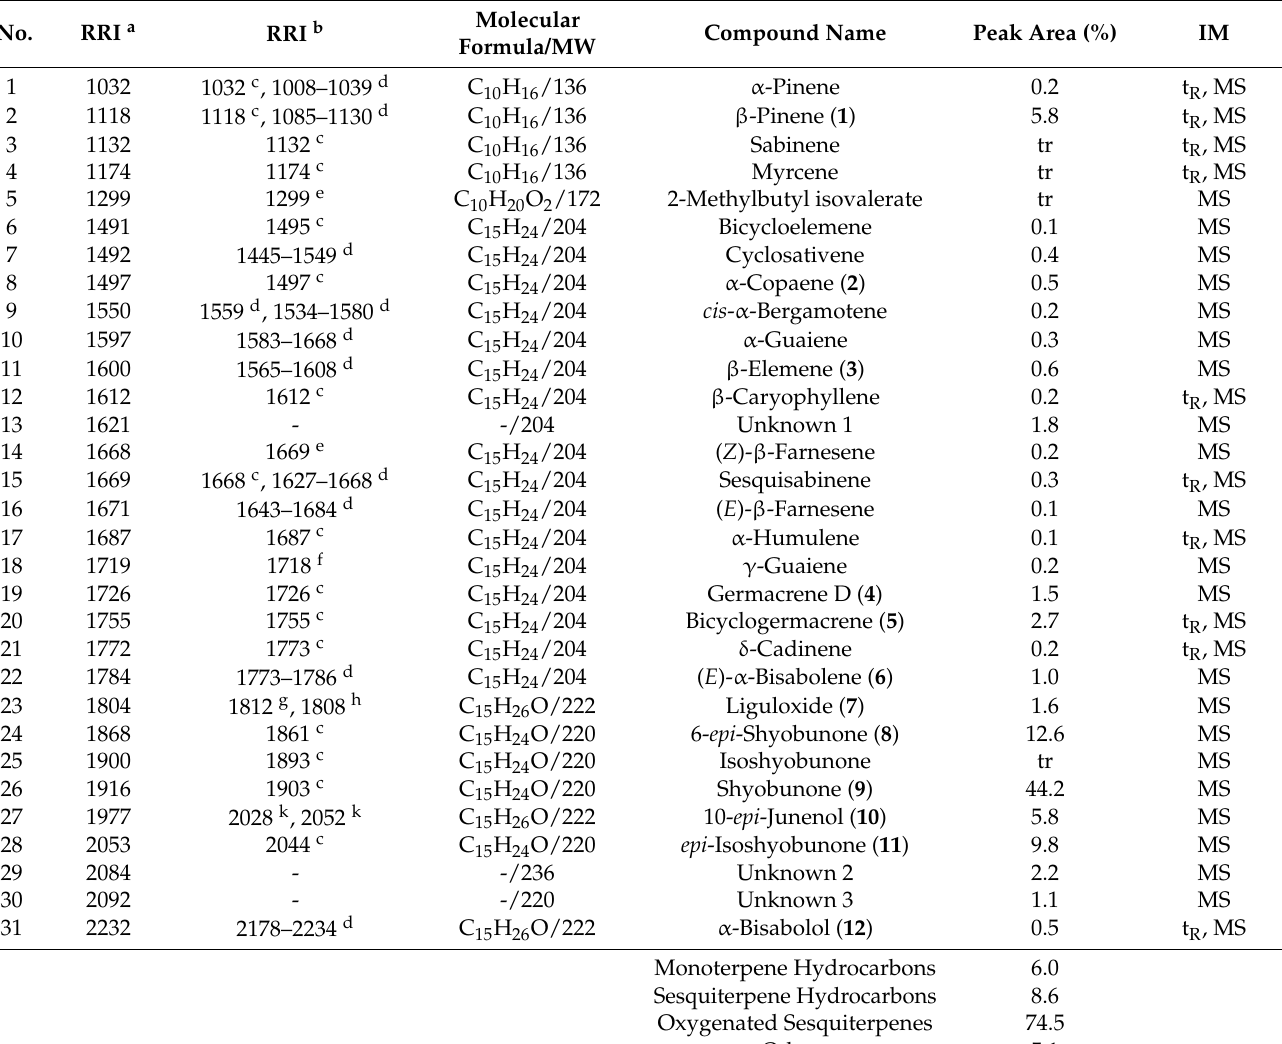
Table 1. Volatile composition of the fruit essential oil of Ferula drudeana